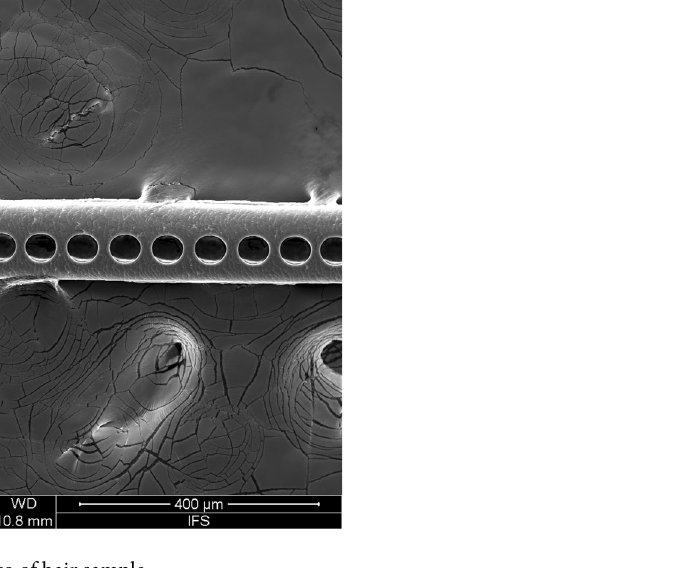
Figure 1. Post-ablation photo of hair